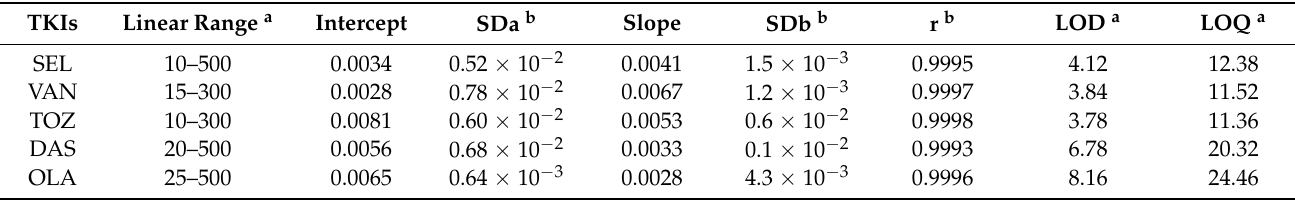
Table 5. Calibration parameters for the analysis of TKIs by the 96-microwell spectrophotometric assay based on their CT reaction with CLA.